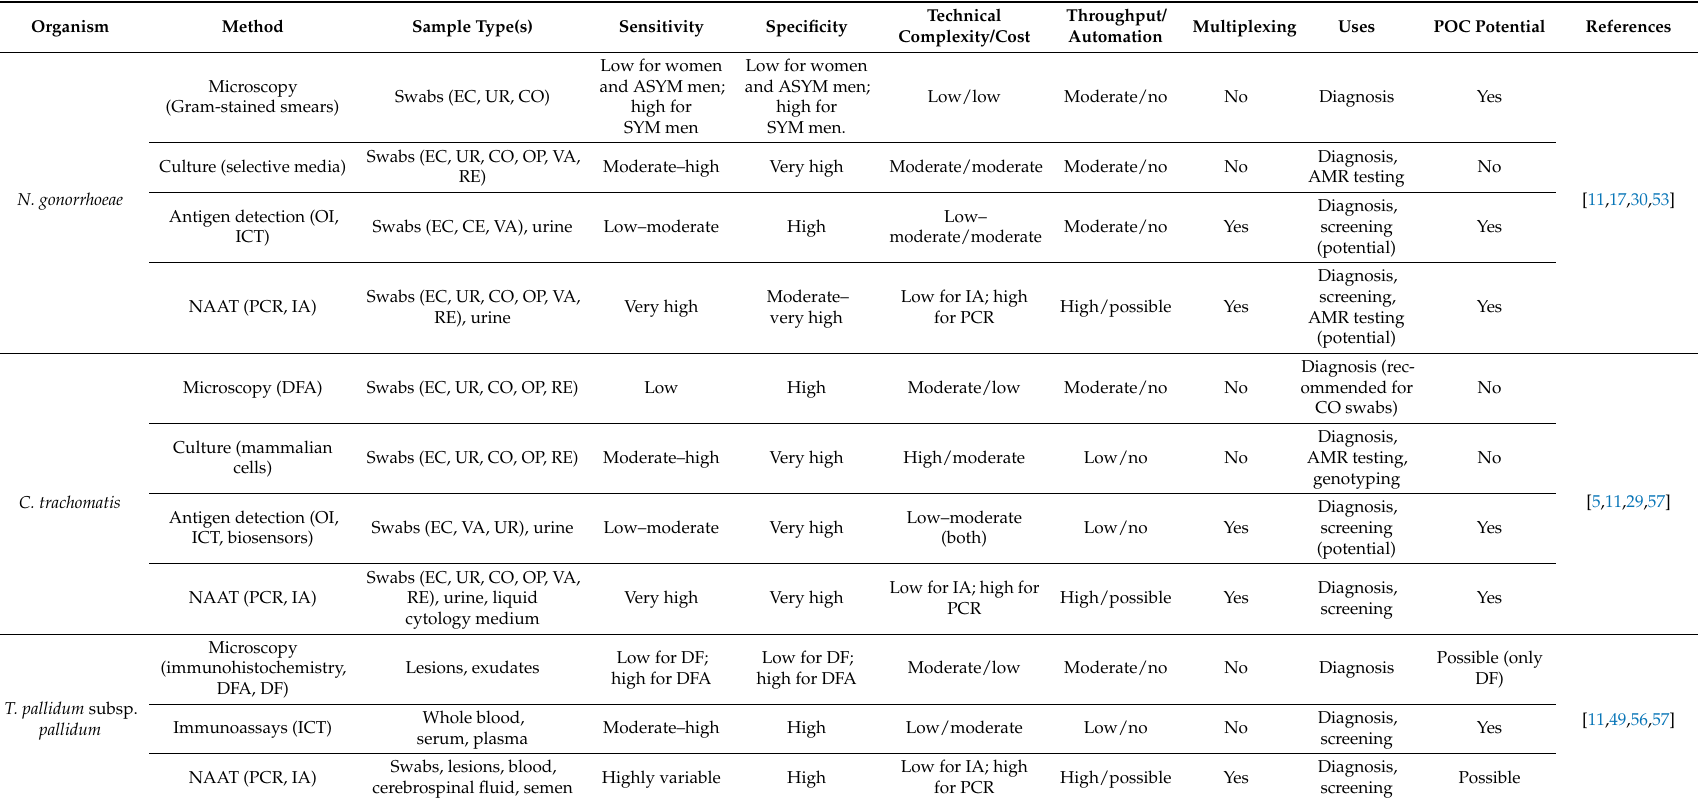
Table 1. Comparison of current laboratory diagnostic tools for sexually transmitted infections (STIs) based on performance, applicability, and adaptability to a point-of-care (POC)